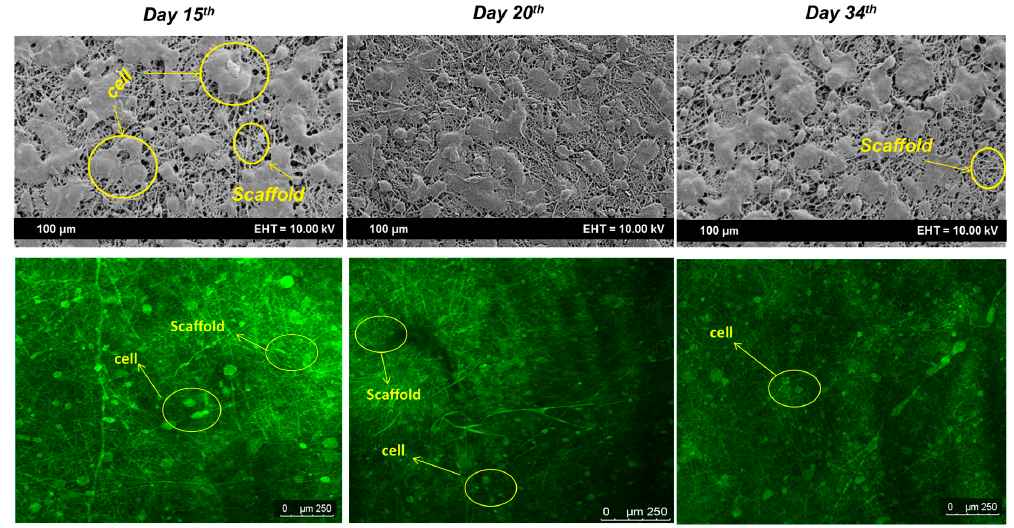
Figure 8. FE-SEM and CLM images of cell attachment on Days 15, 20 and 34 of incubation. The different colors represent the live cells (Green) and scaffold area (Dark).